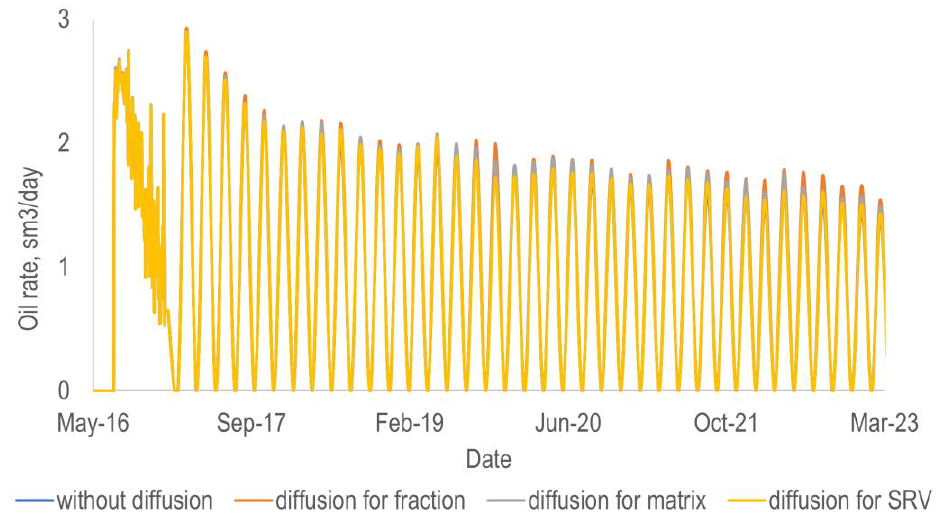
Figure 12. Oil rate for the diffusion coefficients for the fracture zones, SRV, matrix, and without diffusion.